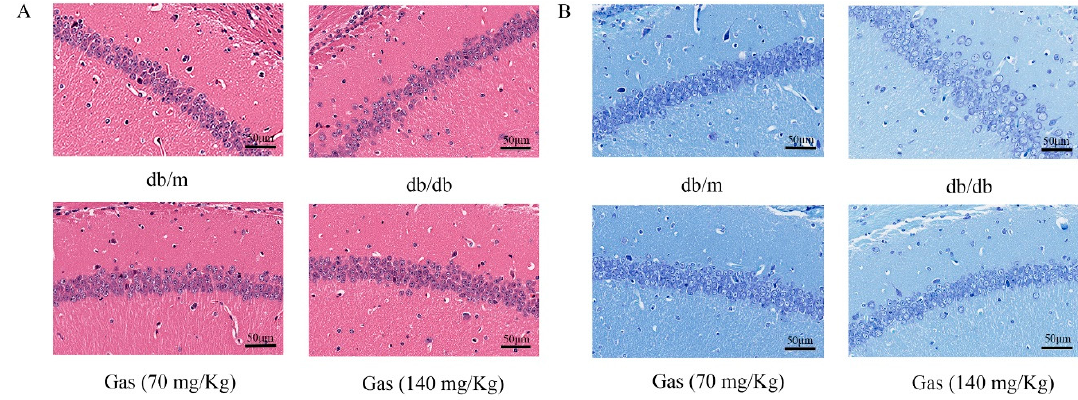
Figure 7. Gas prevented neuronal apoptosis in the hippocampus of db/db mice. ( A ) HE staining in the hippocampal CA1 region for each group. ( B ) Nissl staining in the hippocampal CA1 region for each each group.